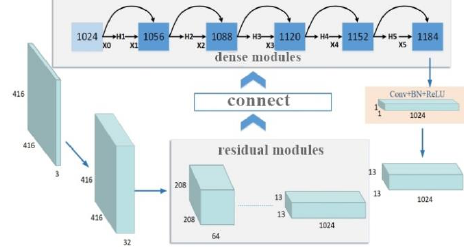
Fig. 1. Schematic diagram of multi-scale YOLO-SKIP network structure. Table 1. Network